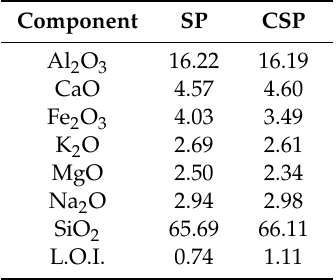
Figure 2. SEM images and EDS analyses for (a) SP and (b) CSP.